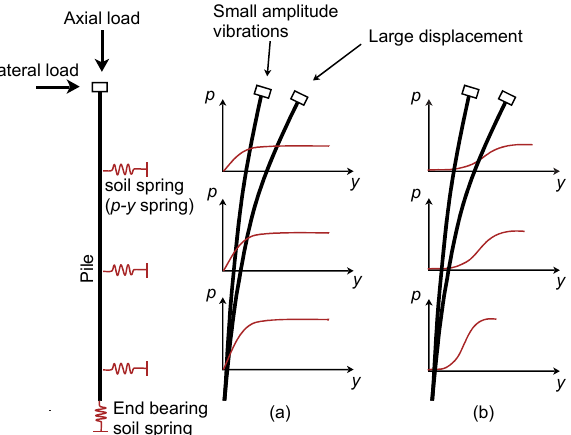
Figure 37. Schematic of soil–structure interaction in piled foundation depending on the shape of